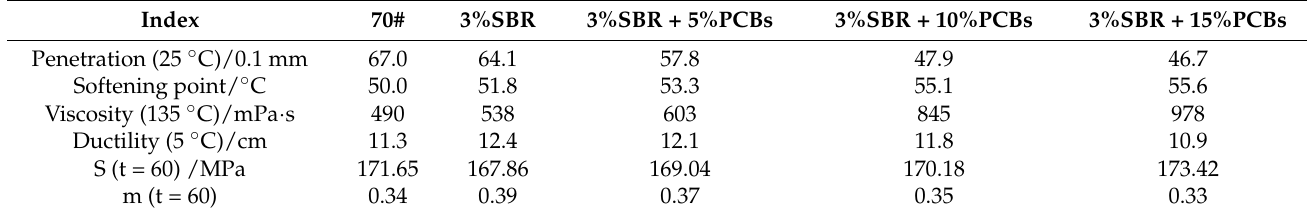
Table 7. Results of conventional properties indexes of